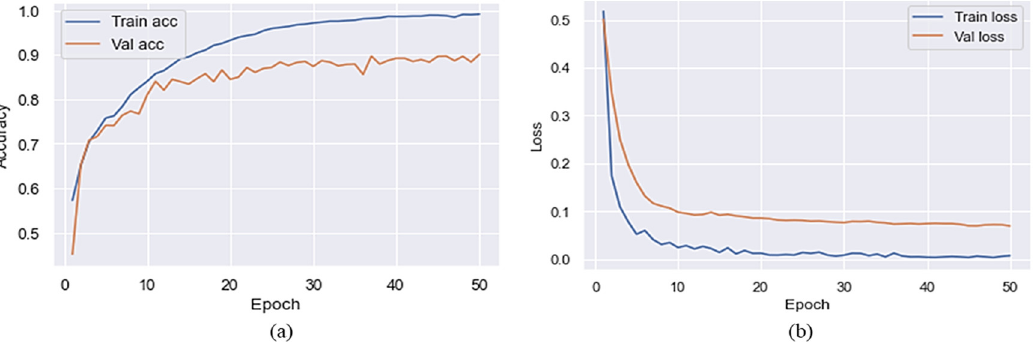
Figure 4. Training/validation accuracy and loss of the proposed model without the preprocessing ( a ) accuracy and ( b ) loss.